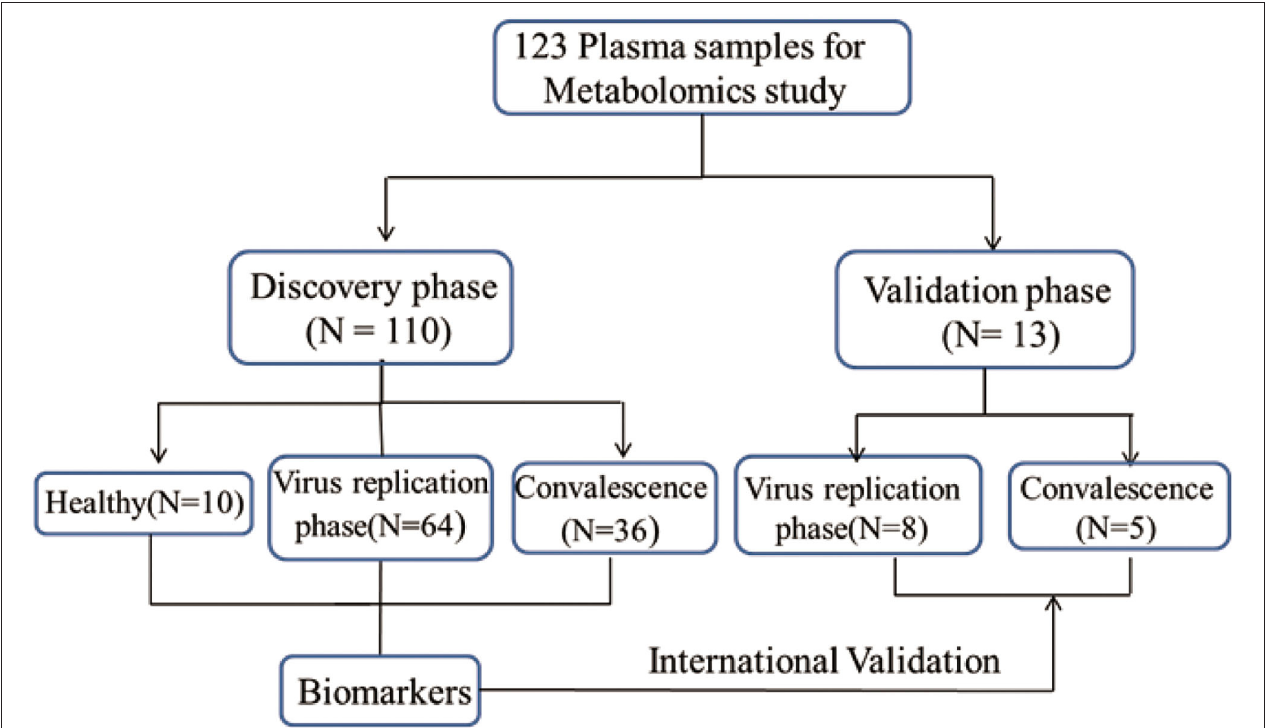
FIGURE 1 | Design of the metabolomics study. This study, involving 123 plasma samples, included both discovery group and validation group. Through the analysis of the data from the discovery set, we screened and identified metabolites that were closely related to COVID-19. To validate the reliability of results from discovery set, an independent set of 13 plasma samples was collected and all samples were correctly identified by a random forest machine learning model based on the identified metabolites ( Supplementary Table 9 ).